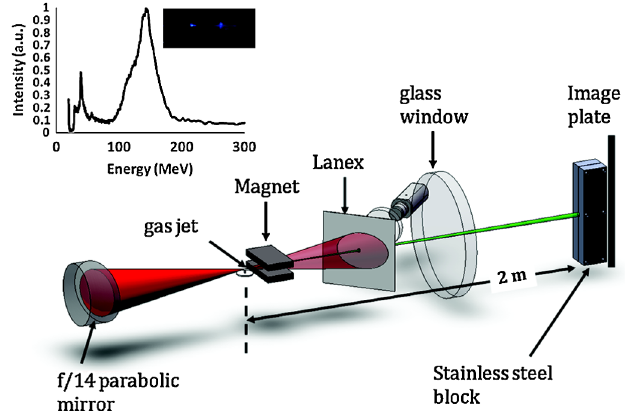
FIG. 1. Experimental schematic for electron beam generation. An f/14 off-axis parabolic mirror focuses a laser beam to a waist of 15 (cid:2) m onto a supersonic gas nozzle. High-energy electron beams generated in the laser-driven plasma are characterized using a magnetic spectrometer and then impinge on a fluorescent screen (Kodak-Lanex), which is imaged using a 12-bit CCD camera. Also depicted in the schematic is the experimental setup to record radiographs of embedded structures of submillimeter resolution at a large distance. The inset shows the dispersed electron beam and the corresponding energy spectrum after passage through the magnetic